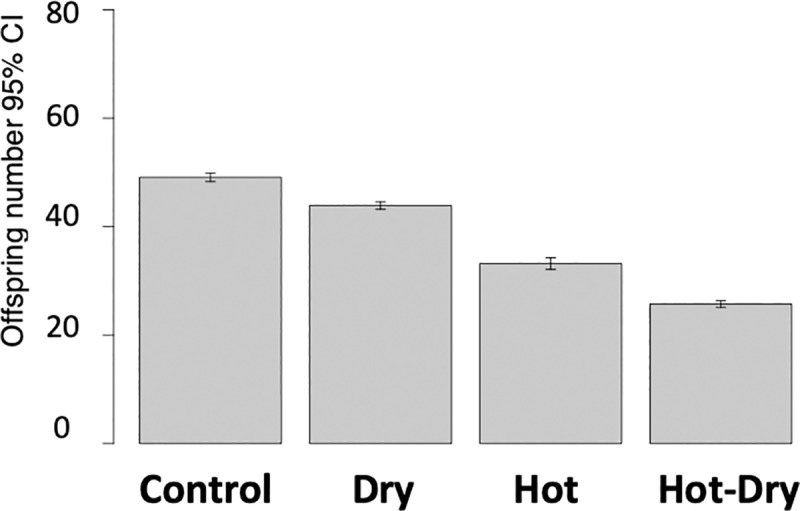
Offspring number of reproducing females in four different conditions:
Control (33°C, 70% r. h.), Dry (33°C, 30% r. h.), Hot (37°C, 70% r. h.),
Hot-Dry (37°C, 30% r. h.).Females could lay eggs for one week and adult offspring was counted five
weeks later.